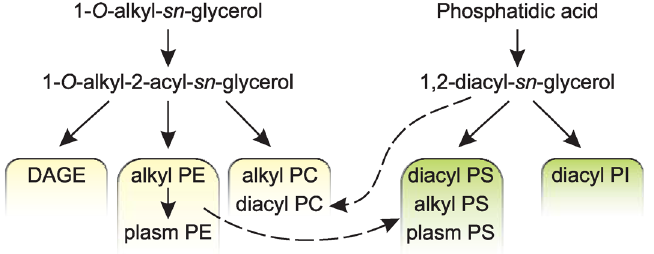
Figure 3. Biosynthesis of GPL and DAGE. Diagram of possible biosynthetic relationships between major classes of structural glycerophospholipids (GPL) and storage diacylglycerol ether (DAGE) in the soft coral Paragorgia arborea , as inferred from comparison of the compositions of the non-polar parts of their molecular species. Ethanolamine, choline, inositol and serine GPL are abbreviated as PE, PC, PI, and PS, respectively. Alkyl, 1- O -alkyl-2-acyl; diacyl, 1,2-diacyl; plasm, 1- O -(alk-1 ′